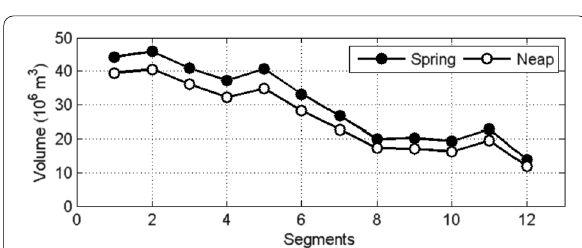
Fig. 4 Volumes of twelve segments of the Pasur River Estuary at high water during both spring and neap